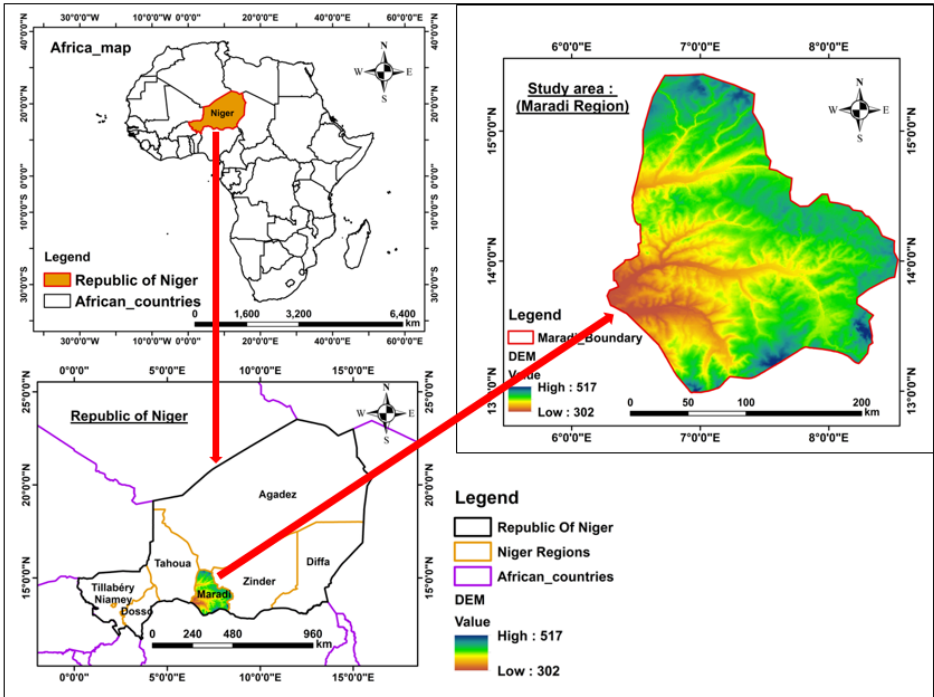
Figure 1. Location map of the study area.